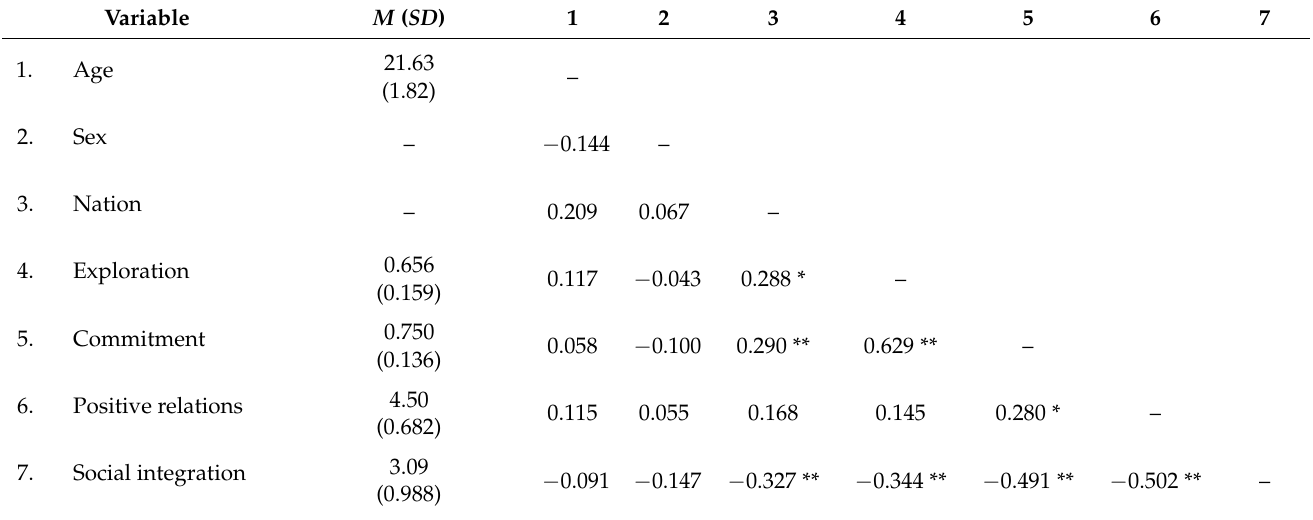
Table 1. Descriptive statistics and correlations for study